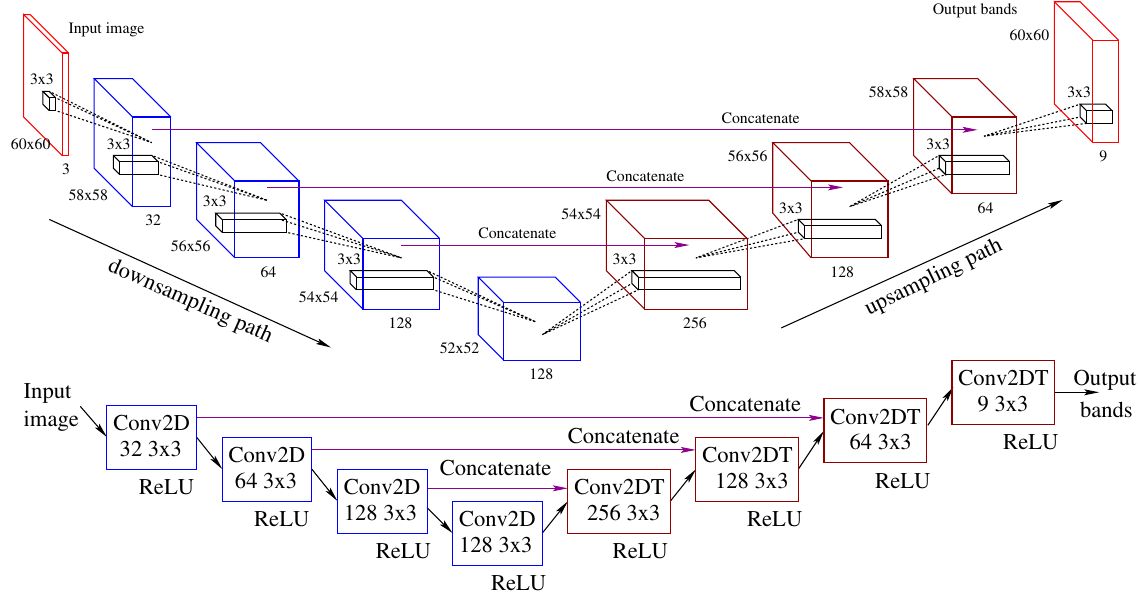
Figure 6. U-Net model considered as generator for a Conditional Generative Adversarial Network architecture. The upper part of the figure shows the feature maps, while the lower part indicates the operation that is carried out. In the downsampling path, blocks labeled Conv2D perform 2D convolutions, while in the upsampling path Conv2DT indicates transposed 2D